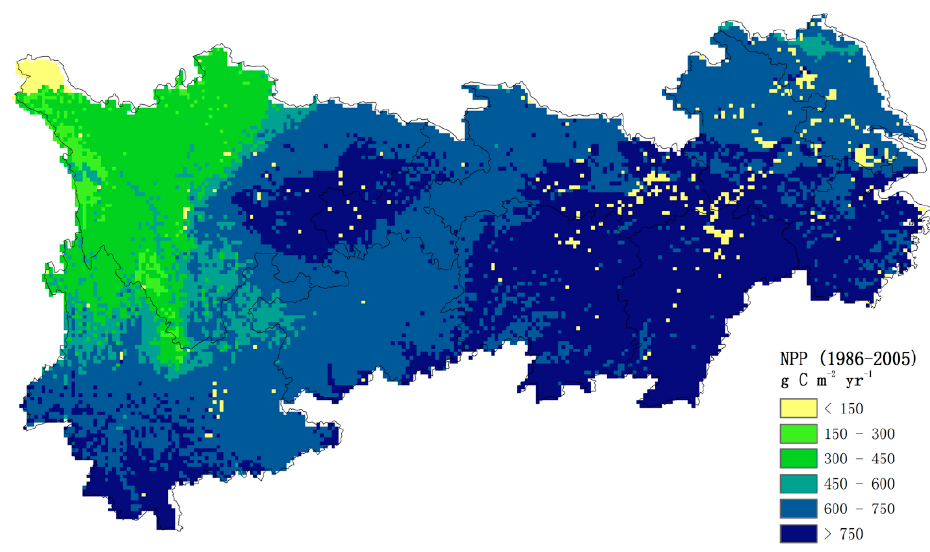
Figure 3. Spatial pattern of NPP in the reference period of 1986 – 2005 in the YREB.